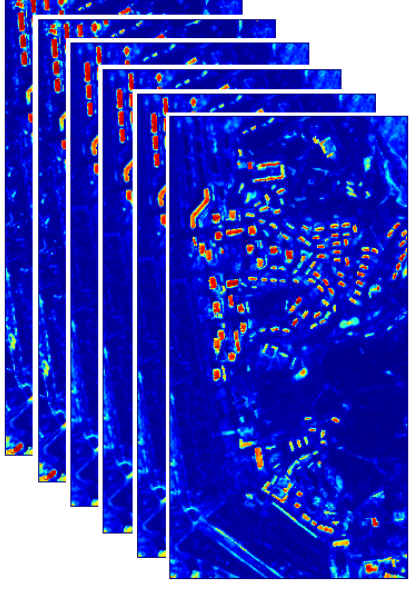
Figure 7. Generated time series BPMs